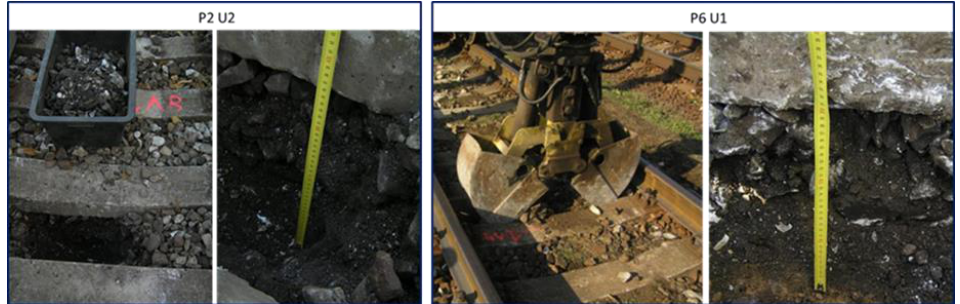
Figure 5. Ground truth data (in sections P2U2 & P6U1).